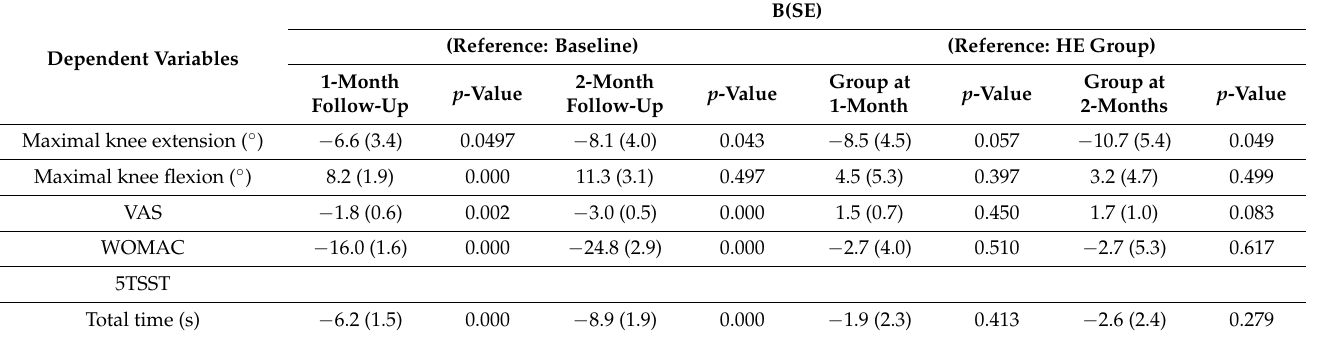
Table 4. Generalized estimating equation analysis for improvements between